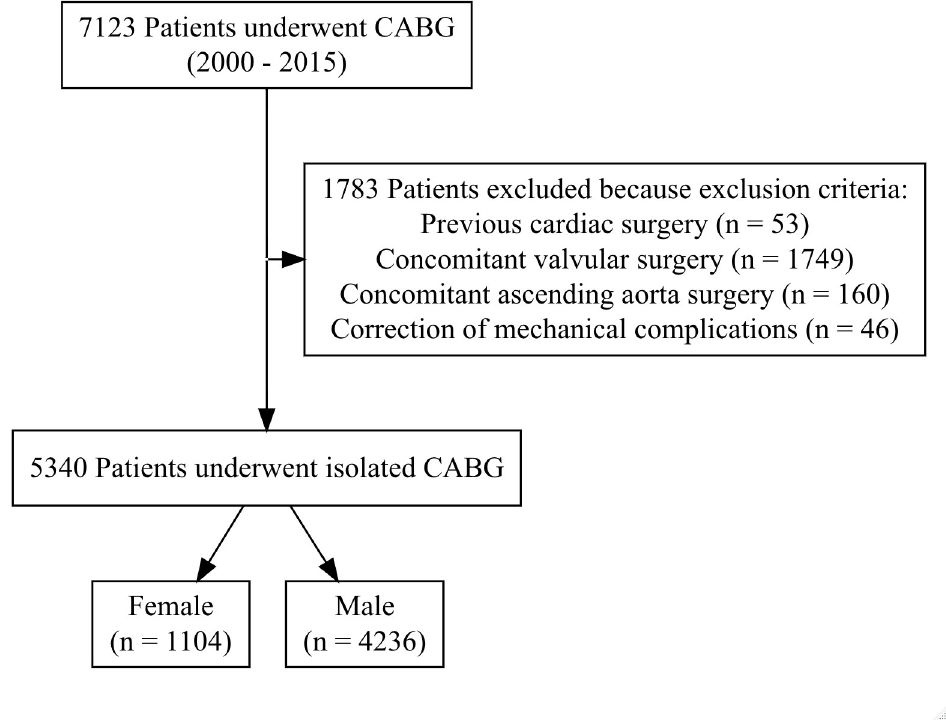
Fig 1. Study flowchart. Exclusion criteria for 7123 patients who underwent coronary artery bypass grafting (CABG) in Northern Portugal.